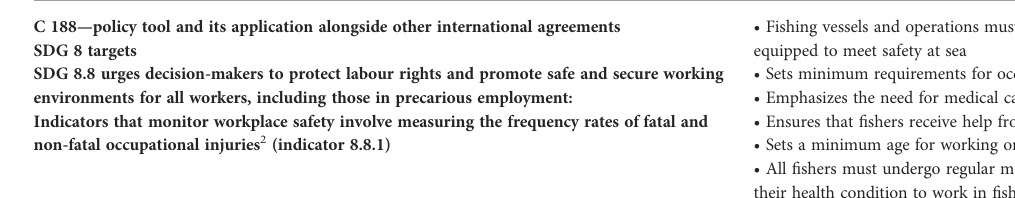
TABLE 3 International Labour Organization policy instruments in the case of small-scale dive fi sher labour, occupational health and safety, and social protection. Type of decent work and labour policy